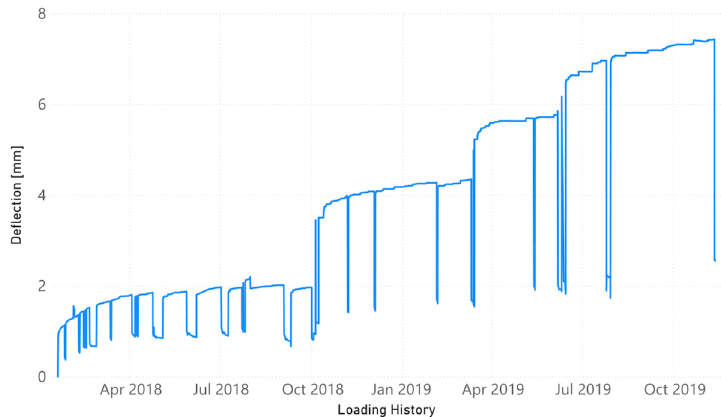
Figure 4. Evolution of midspan deflection along the loading history.